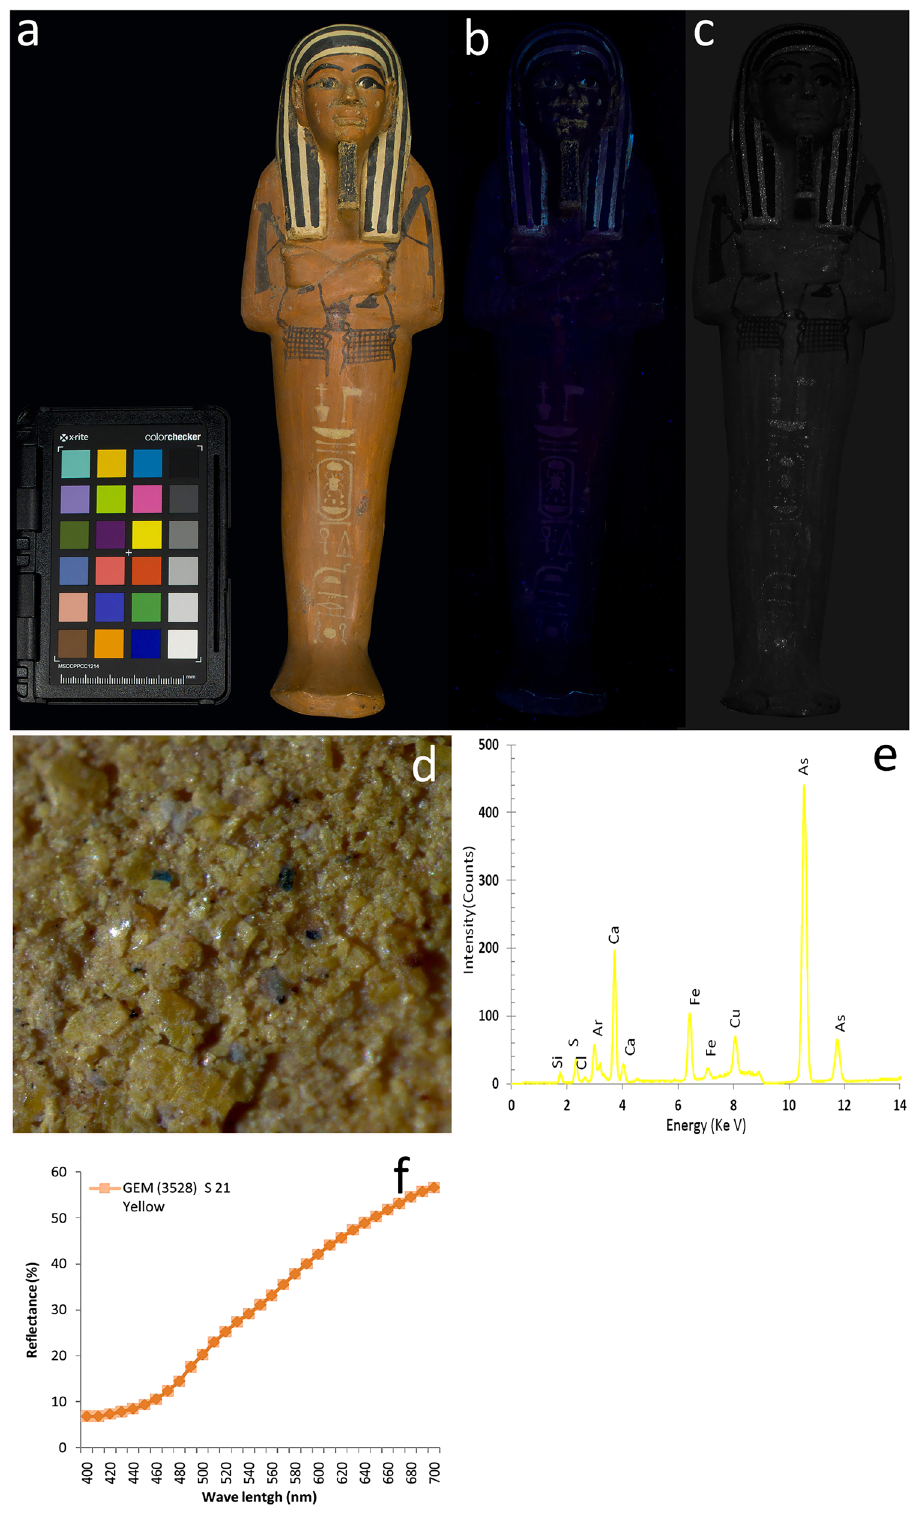
Figure 5: Analytical characterization of the yellow painted layer ( Object GEM 3528, Spot 21 ) : ( a ) visible image; ( b ) UV lumi - nescence image; ( c ) VIL image; ( d ) an optical micrograph; ( e ) XRF spectrum; and ( f ) visible re fl ectance